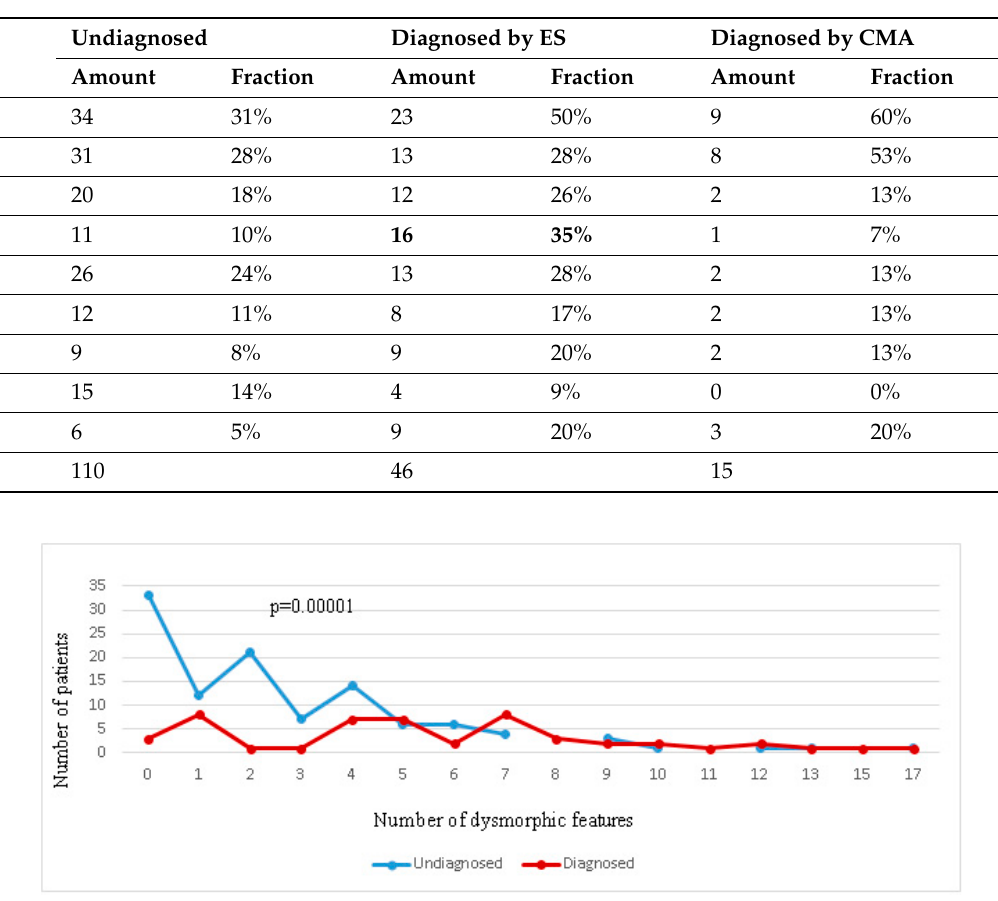
Table 5. Comparison of the most common clinical and dysmorphic features.